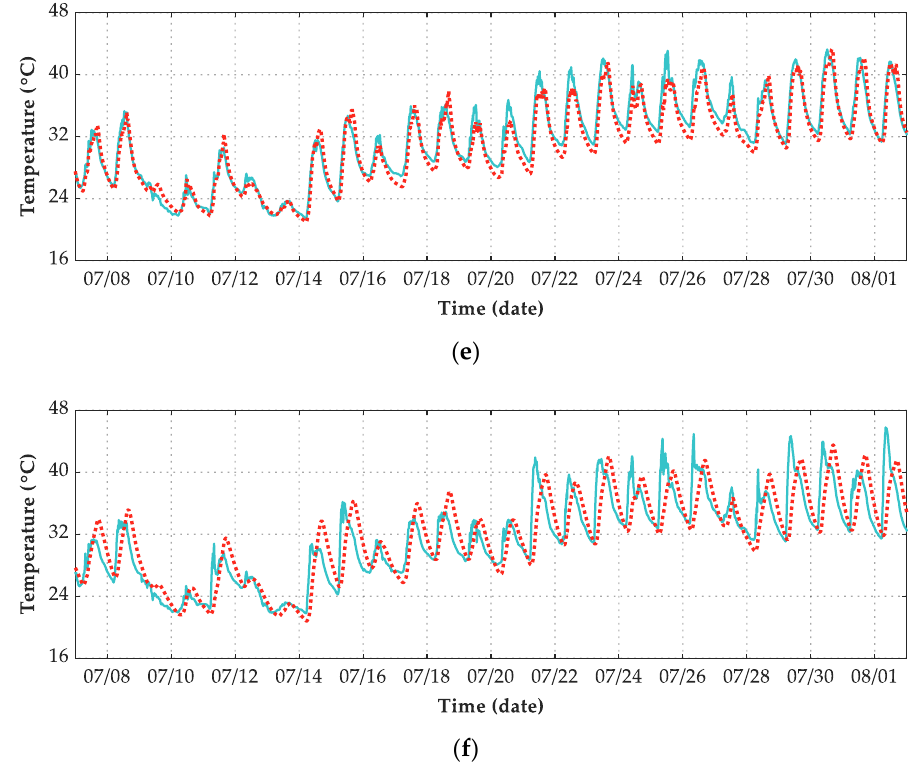
Figure 16. Time-temperature curve of 6 points. ( a ) TS; ( b ) BS; ( c ) SS; ( d ) NS; ( e ) SP; ( f ) EP.